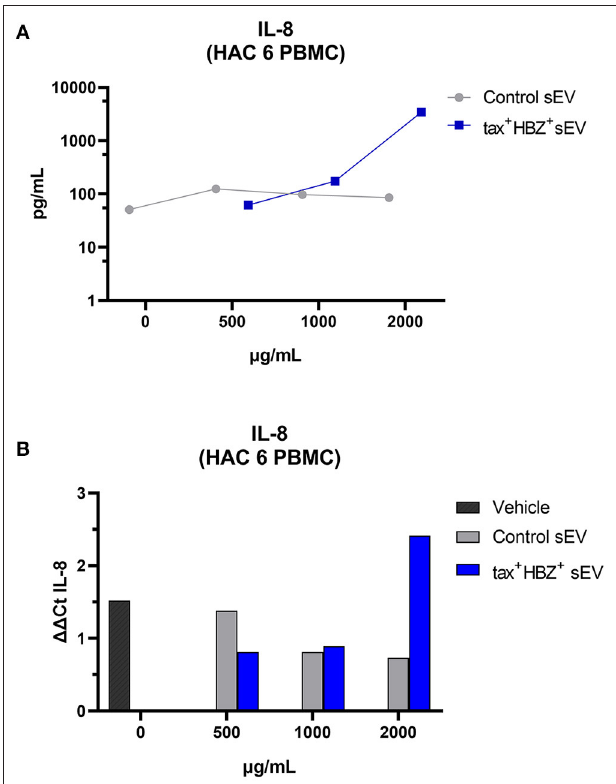
FIGURE 5 | Interleukin-8 expression and secretion in HTLV-1-infected PBMCs treated with tax + HBZ + sEV. (A) The secretion of IL-8 was analyzed in the total protein extract of HAM/TSP PBMCs ( n = 1) treated with 500, 1,000, and 2,000 µ g/ml of tax + HBZ + sEV. Graph A shows the average IL-8 concentration in pg/ml in response to each sEV treatment. (B) The same conditions were analyzed by qPCR. Graph B shows the average IL-8 relative expression ( 11 Ct) in response to sEV